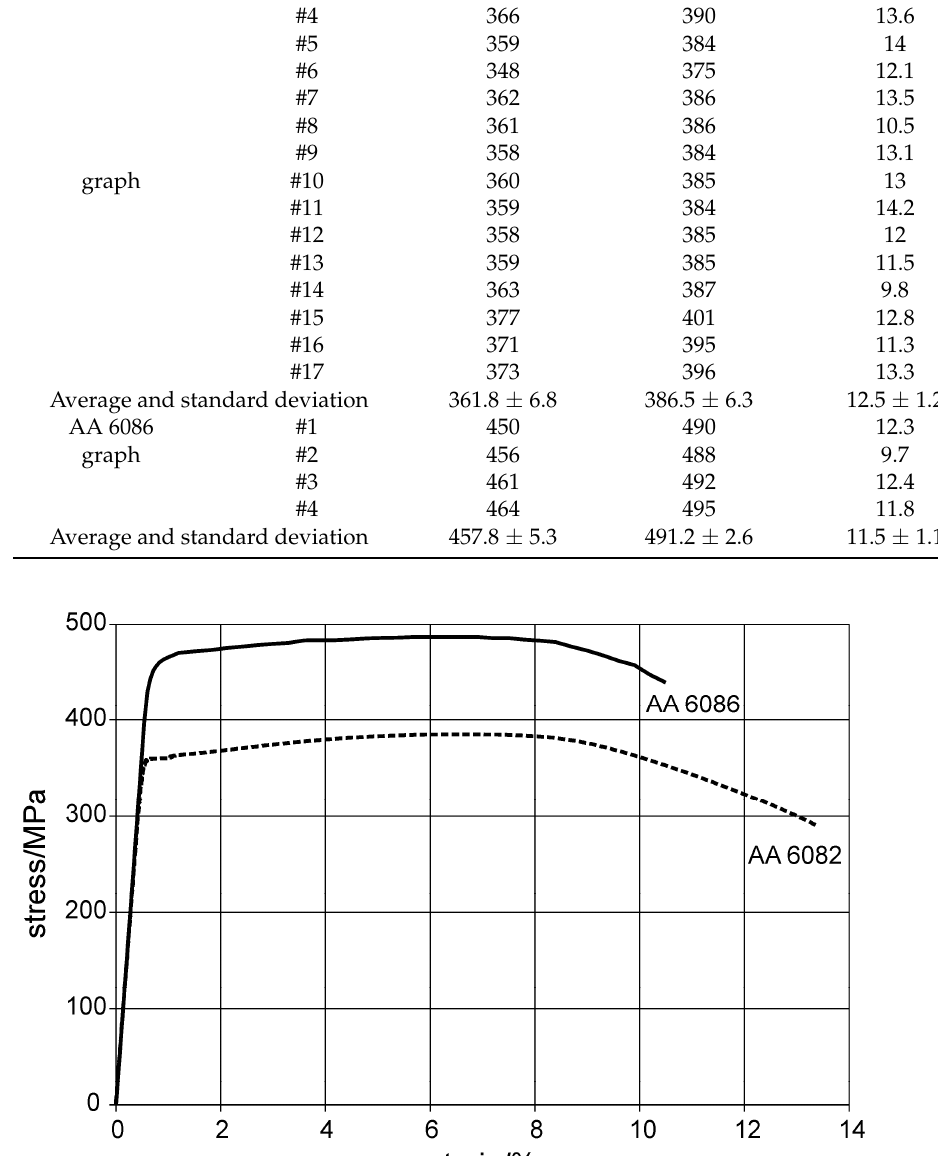
Figure 14. Typical tensile diagrams of the alloys AA 6082 (R p0,2 = 360 MPa, R m = 385 MPa, A = 13.0%, blue) and AA 6086 (R p0,2 = 456 MPa, R m = 488 MPa, A = 9.7%, red) in the T6 temper.